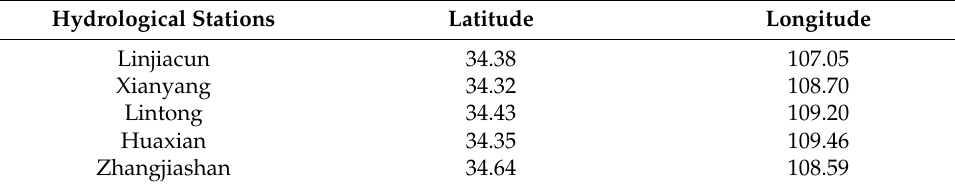
Table 2. 5 National Hydrological Stations in the Wei River Basin. Hydrological